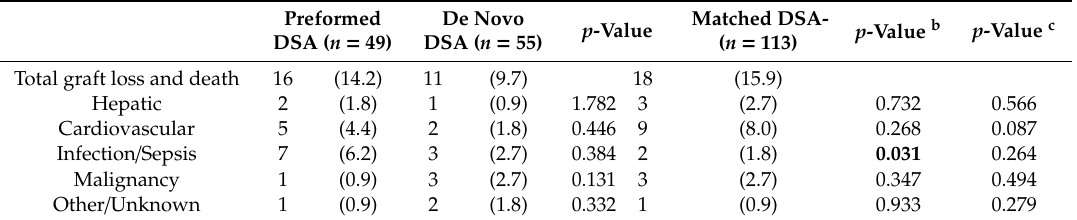
Table 3. Reasons for one-year graft loss and mortality in preformed DSA, de novo DSA, and matched DSA-negative (matched DSA-) LT organ recipients a